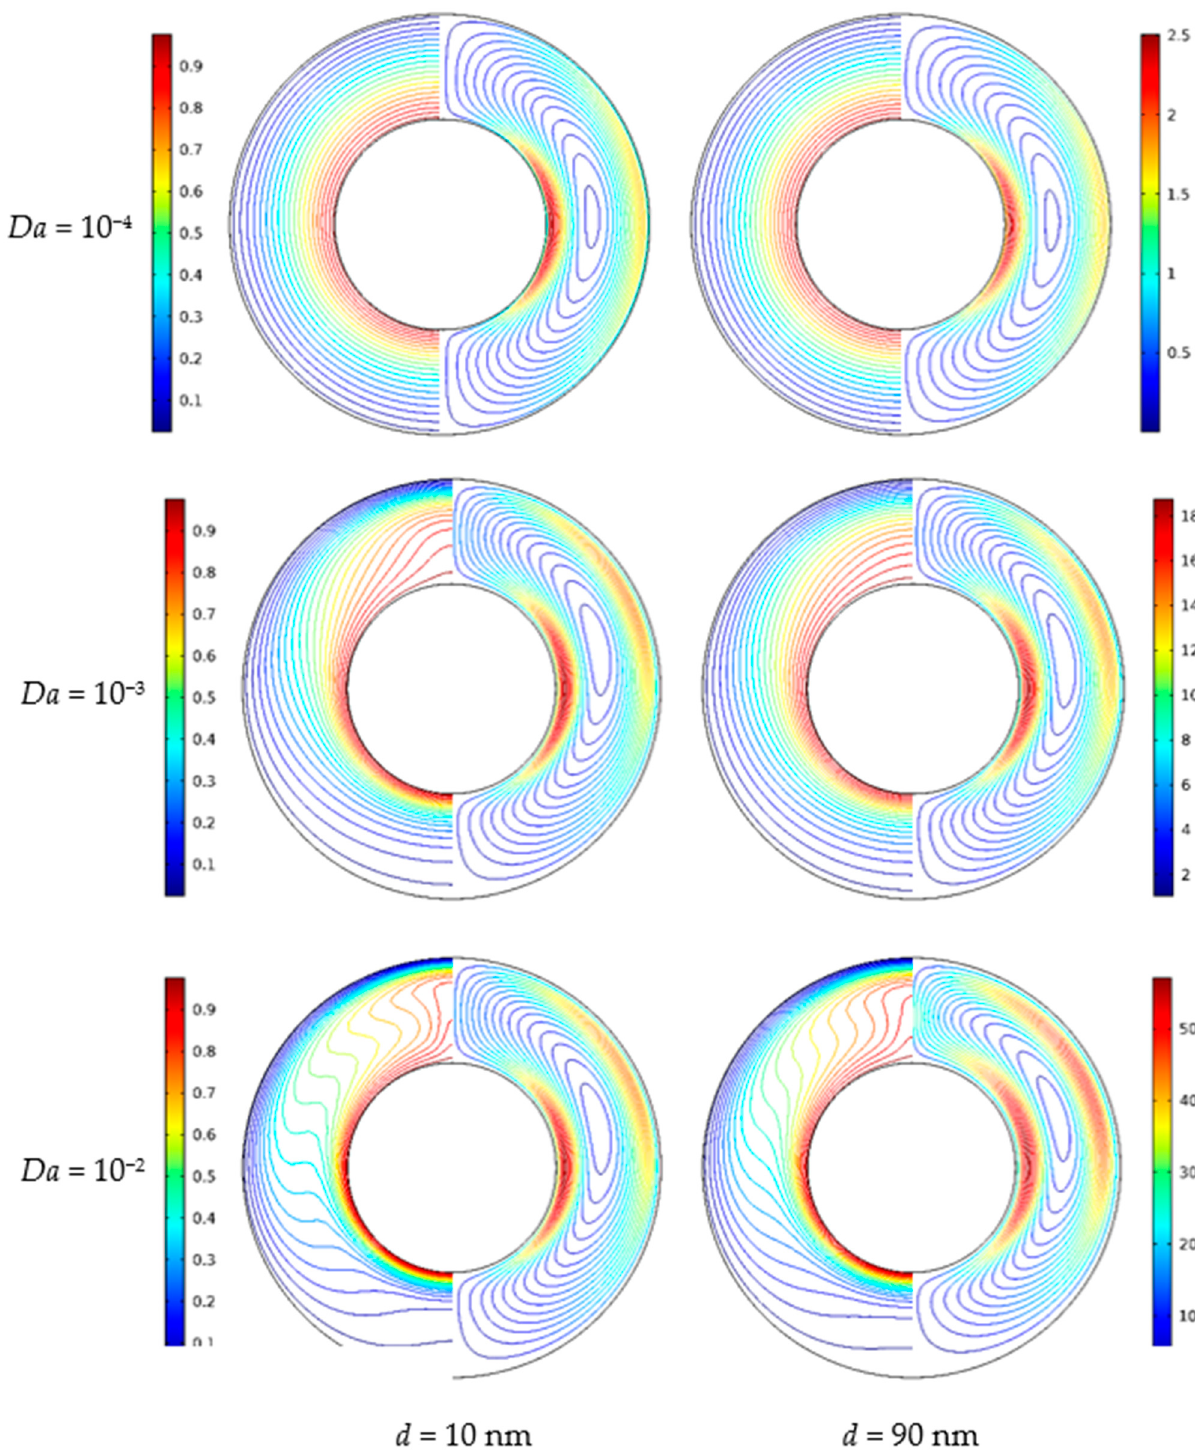
Figure 11. Isotherms (left) and streamlines (right) for Cu–water nanofluid for different nanoparticle diameters ( d sp ) and Darcy numbers ( Da ) at Ra = 5 × 10 4 , ϕ = 0.05, ε = 0.5, and RR = 2.